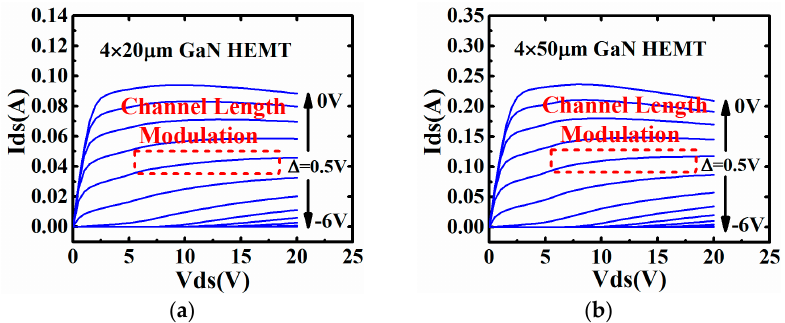
Figure 3. Channel length modulation effect in Static IV curves of 0.1 µm AlGaN/GaN HEMT with different gate width: ( a ) 4 × 20 µm and ( b ) 4 × 50 µm.